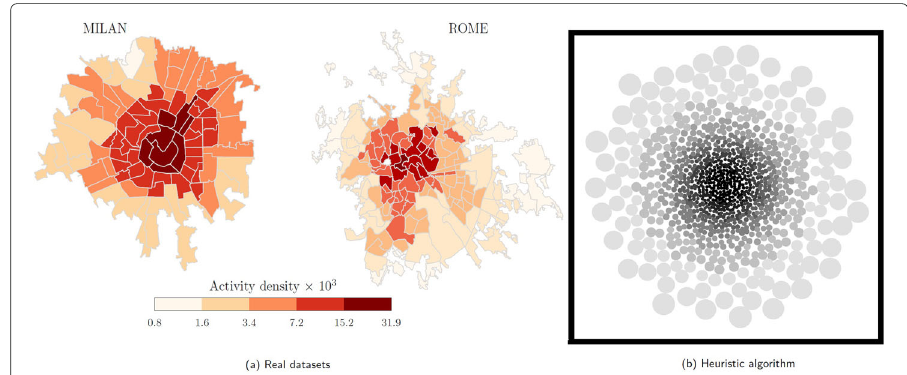
Fig. 1 Qualitative comparison between real datasets from an experimental study (De Nadai et al. 2016), and the output of our algorithm. a Experimental results about human digital activity density in the cities of Milan and Rome, Italy. The highest density is registered in central areas, while lower densities are observed in peripheral ones. b Using our algorithm, we generate L = 1,000 circular locations distributed in rings of decreasing densities. The first few rings contain the denser locations (darker central regions) and may parallel the city center of a urban environment, while the outer rings are less dense and represent peripheral areas (light gray regions). Source of a : (De Nadai et al. 2016). Parameters used to generate b : D = 1,000, (cid:6) min = 3, = 30, and γ = 2.1. Details of the generative algorithm used are available in Appendix (cid:6) max